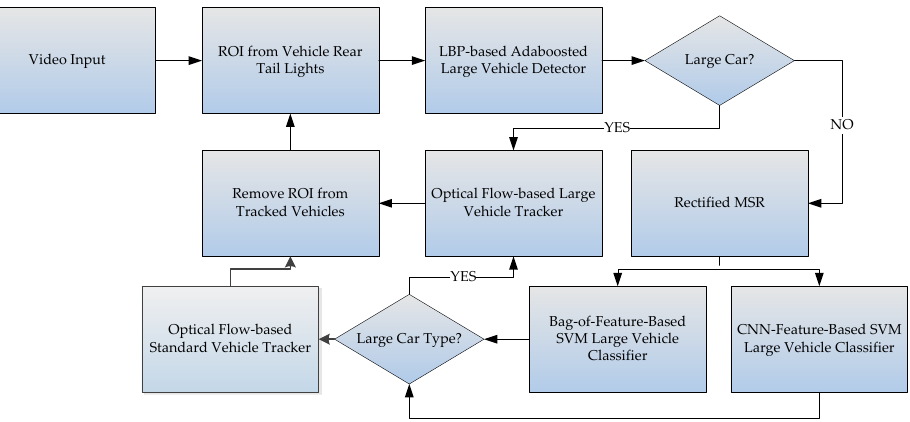
Figure 2. The flowchart for the large vehicle detector.